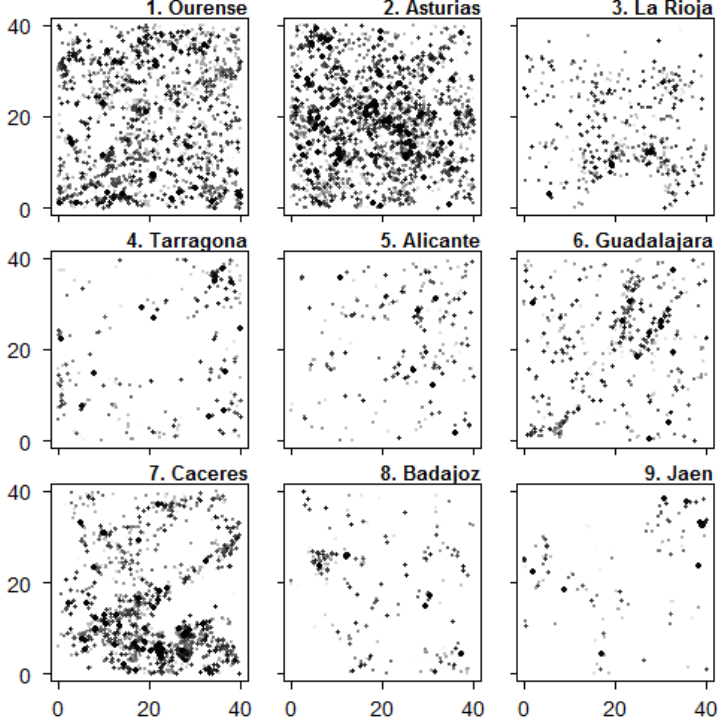
Figure 4. Spatial positions of the 7790 human-caused fires (HCFs) in the study. The biggest and darkest points correspond to recent fires while the lightest points occurred earlier.